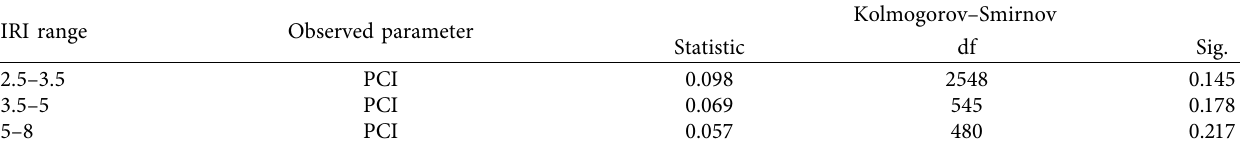
Table 1: Kolmogorov–Smirnov test results for PCI normal distribution.